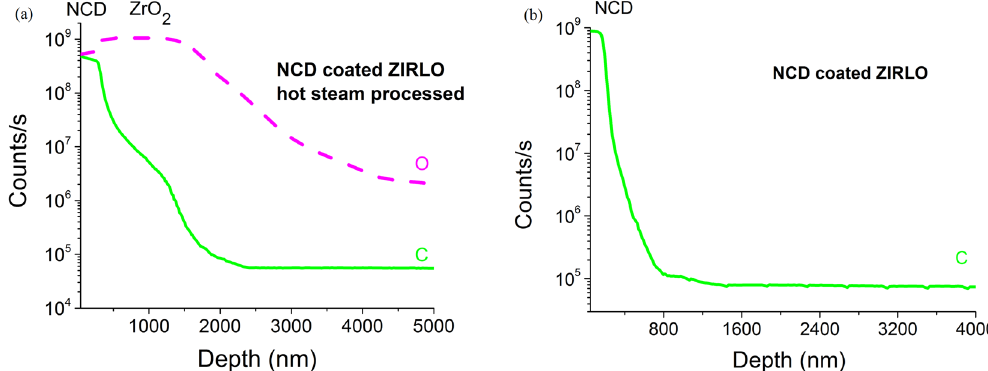
Figure 7. SIMS data showing that after 4 days of hot steam exposure at 400 °C, the ZrO 2 layer in 300 nm NCD- coated ZIRLO contained C to a depth bigger than 1.5 µ m ( a ), whereas in non-exposed NCD-coated ZIRLO, the majority of the carbon was contained only within the thin (0.4 µ m) NCD layer ( b ). The depth profiles of C and O are in units of counts/s and labelled in the graphs.